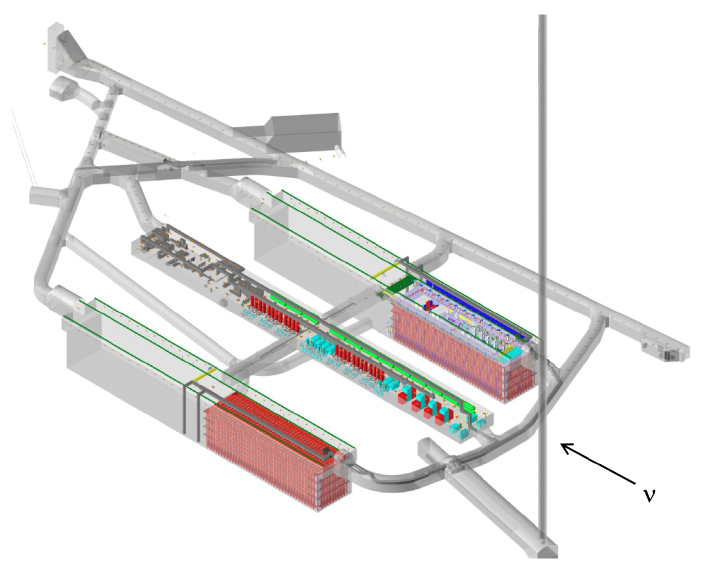
Figure 7. Underground caverns for the DUNE FD and cryogenics systems at SURF in South Dakota. The drawing shows the cryostats (red) for the first two FD modules. The vertical shaft providing access to the DUNE underground area appears on the